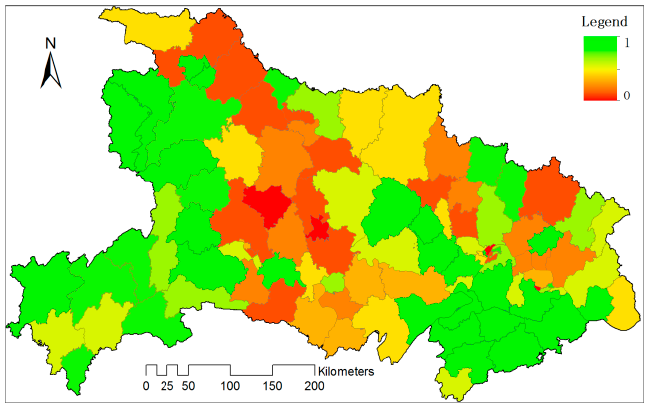
Figure 11. The significance level for the change of DC, at the confidence level of 0.05.